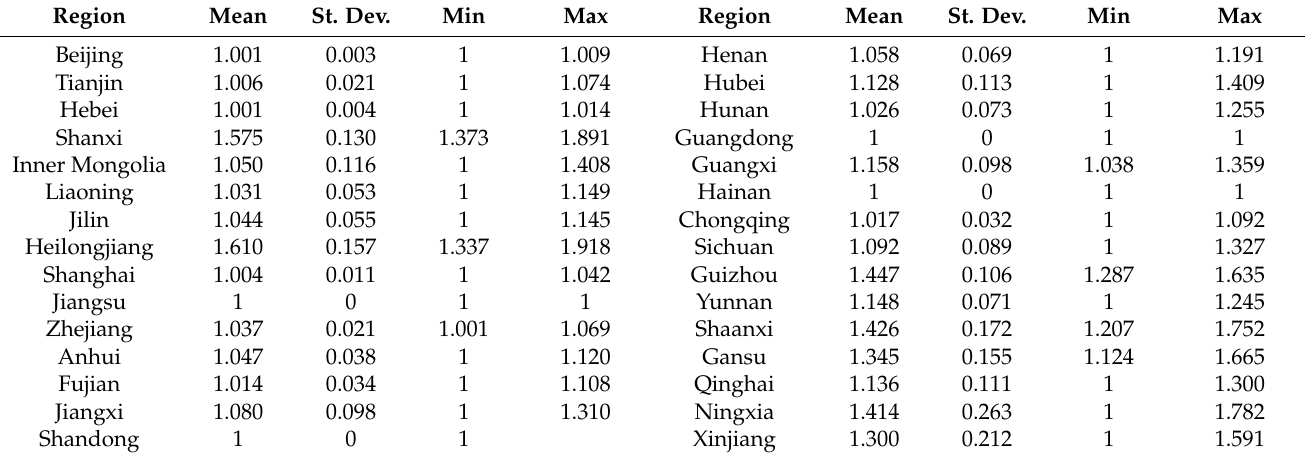
Table A1. Summary statistics of estimated opportunity cost from 2003 to 2015 (full sample).